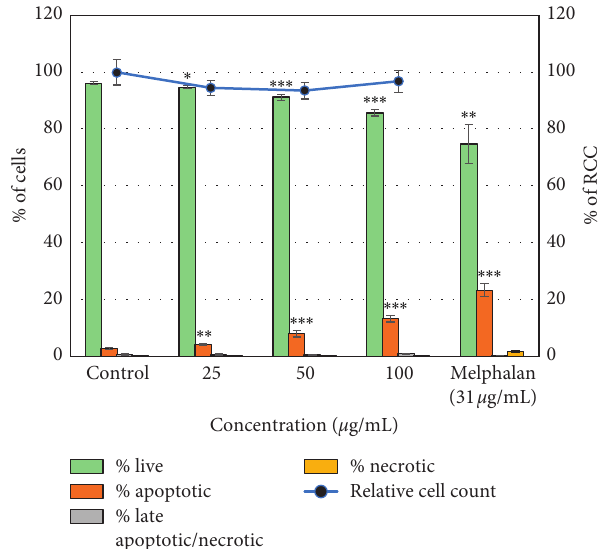
Figure 3: The cytotoxic effect of the B. asphodeloides ethanol leaf extract towards the human dermal fibroblast (MRHF). Data are presented as the mean ± SD ( n � 3). ∗ P < 0 . 05, ∗∗ P < 0 . 01, and ∗∗ ∗ P < 0 . 001 compared to the control.